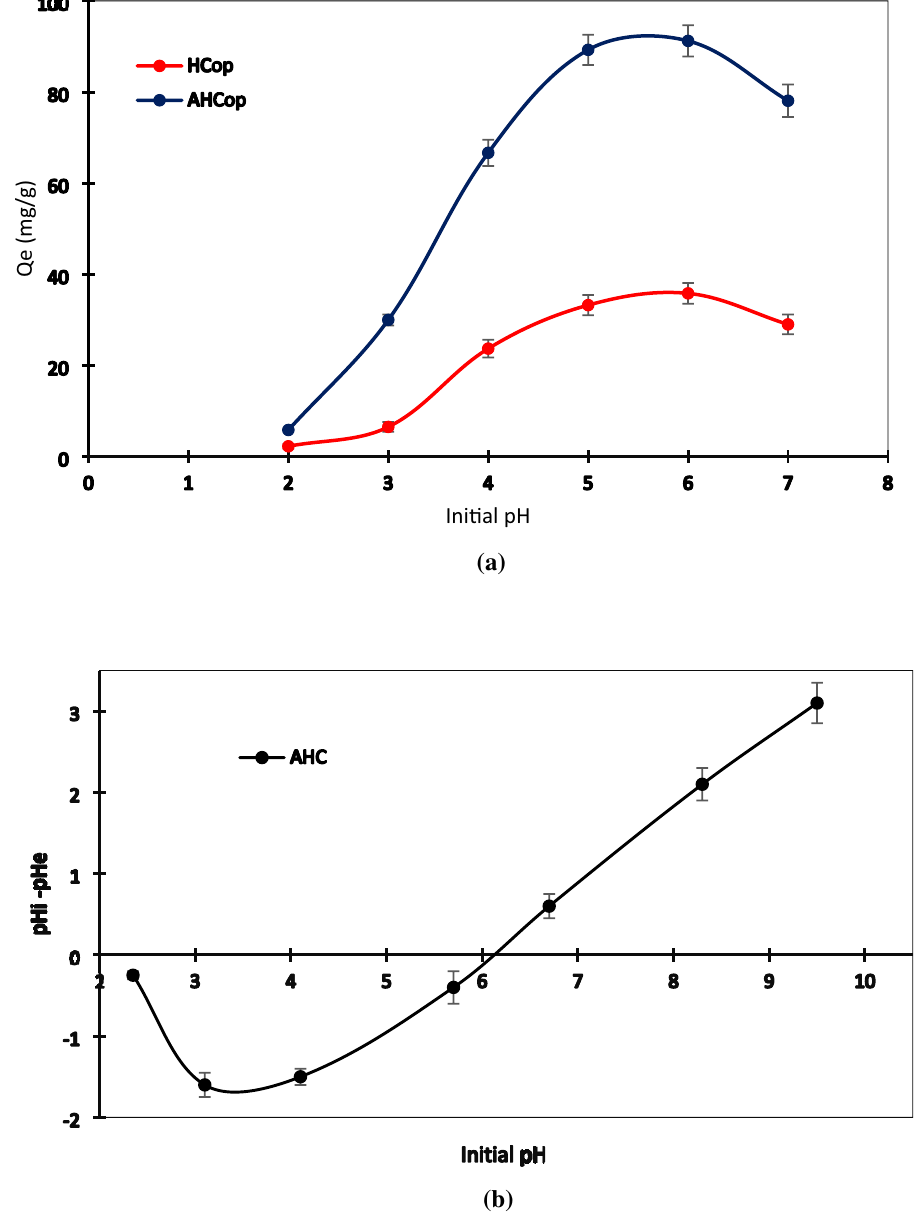
Figure 6. Effect of pH on adsorption of Pb 2+ onto AHCop and HCop ( a ); Point of zero charge of AHCop ( b ). Error bars represent the standard deviation of three repeated